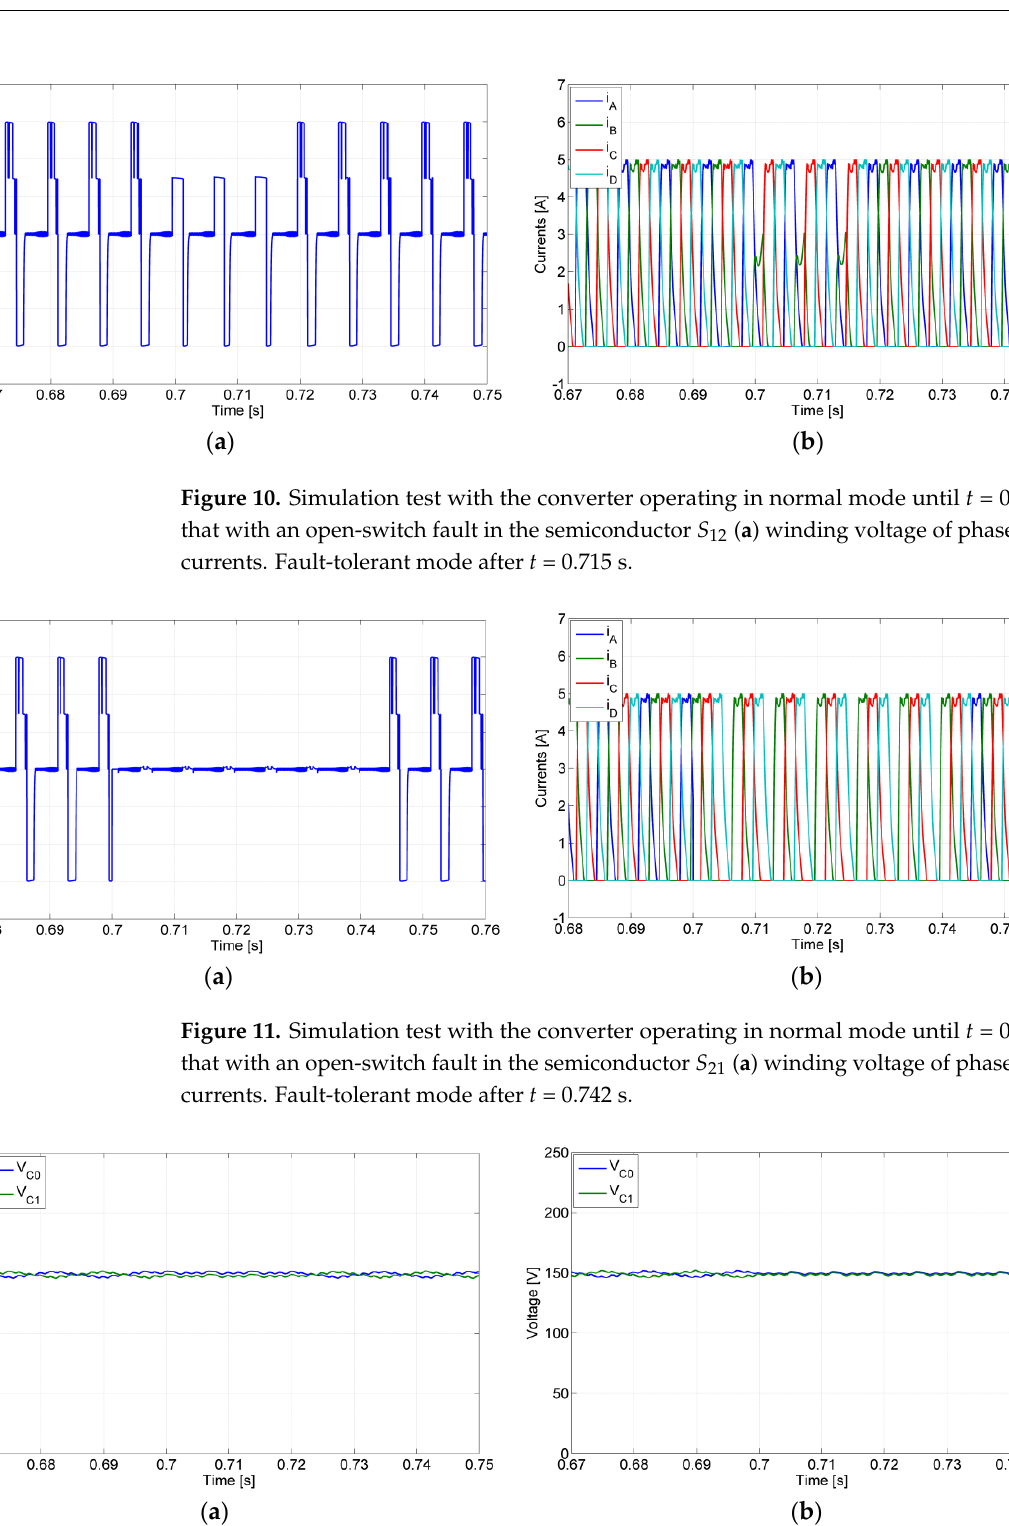
Figure 12. Simulation test with the converter operating in normal mode until t = 0.695 s and after that with an open-switch fault ( a ) voltage capacitors for open-switch fault in the semiconductor S 12 ; ( b ) voltage capacitors for open-switch fault in the semiconductor S 21 . Fault-tolerant mode after t = 0.742 s.